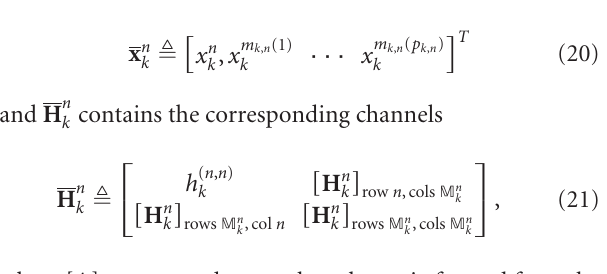
Figure 4: Geometry of a 25-pair